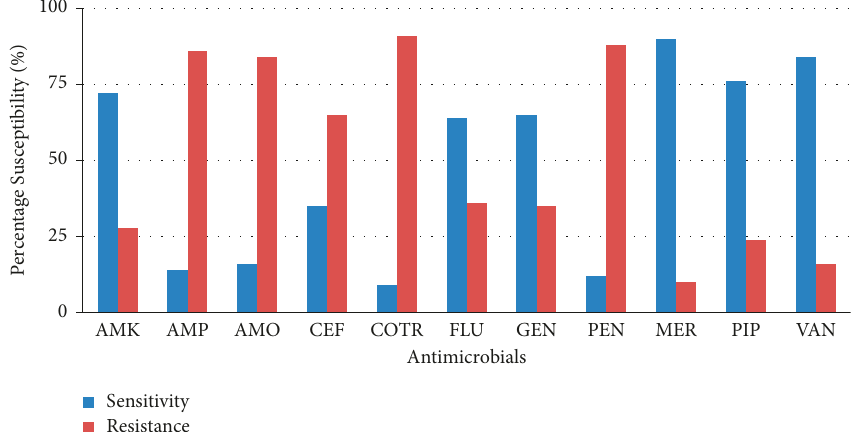
Figure 3: Overall antimicrobial sensitivity/resistance pattern of Gram-positive isolates. Key: AMK, amikacin; AMP, ampicillin; AMO, amoxiclav; CEF, cefuroxime; CO-TR, cotrimoxazole; FLU, flucloxacillin; GEN, gentamicin; PEN, penicillin; MER, meropenem; P/T, piperacillin/tazobactam; VAN,